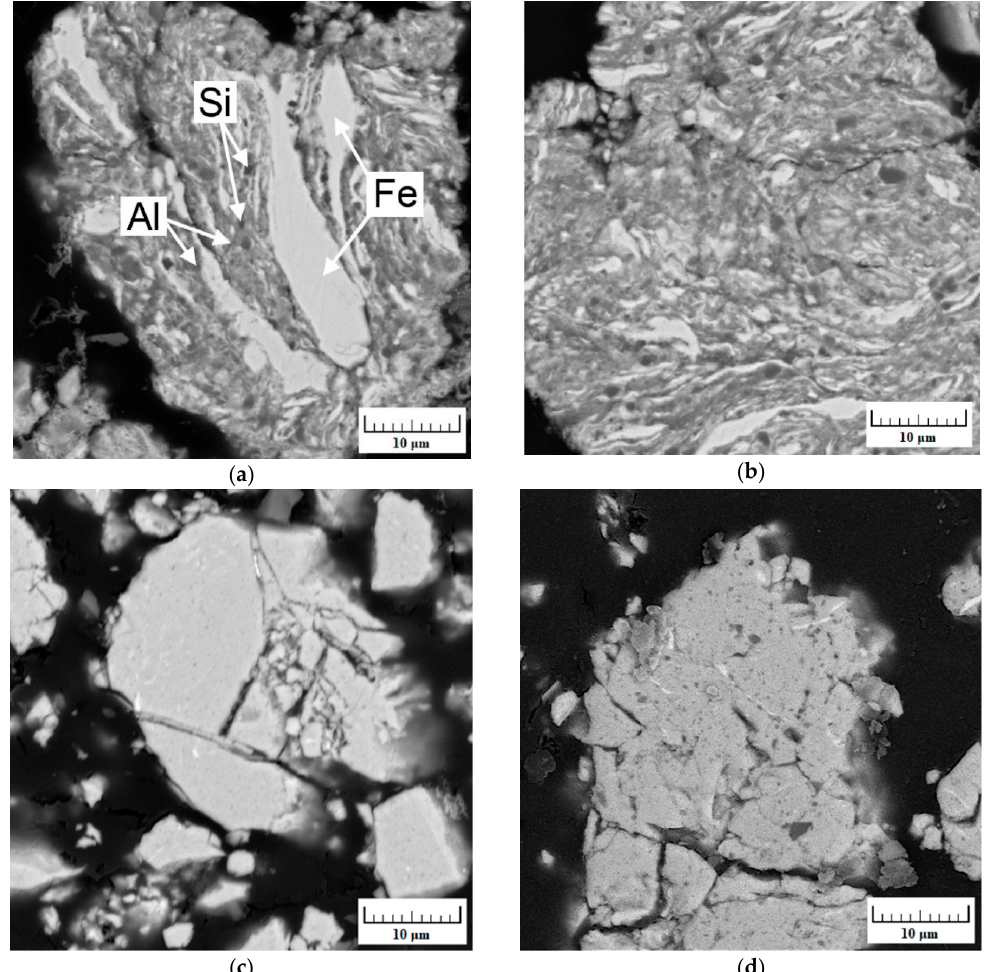
Figure 5. The SEM micrographs of the FeAl30Si10 alloy after: ( a ) 0.5 h, ( b ) 1 h, ( c ) 2 h, ( d ) 4 h of MA.